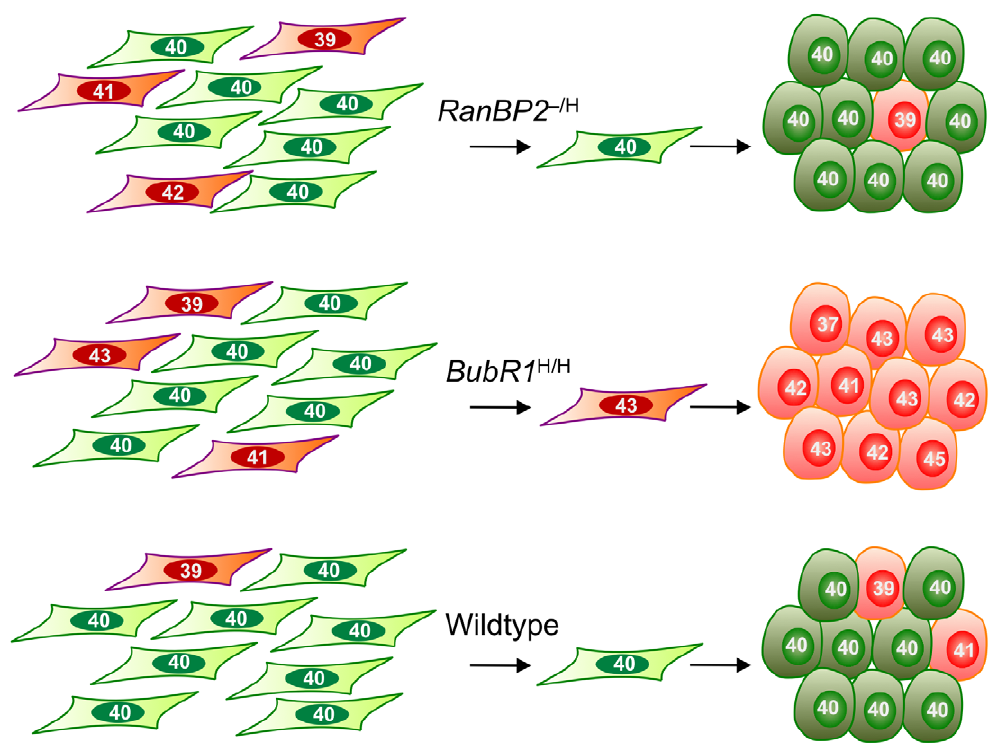
Figure 6. Model illustrating the contrasting effects of W-CIN gene defects on iPSC genomic integrity. RanBP2 hypomorphic iPSCs originate from MEFs with normal chromosome numbers and exhibit a high degree of chromosome number stability. BubR1 hypomorphism results in selective reprogramming of aneuploid cells and yields chromosomally unstable iPSCs. iPSC cultures established from wildtype MEFs typically contain relatively small subpopulations of cells with abnormal chromosome